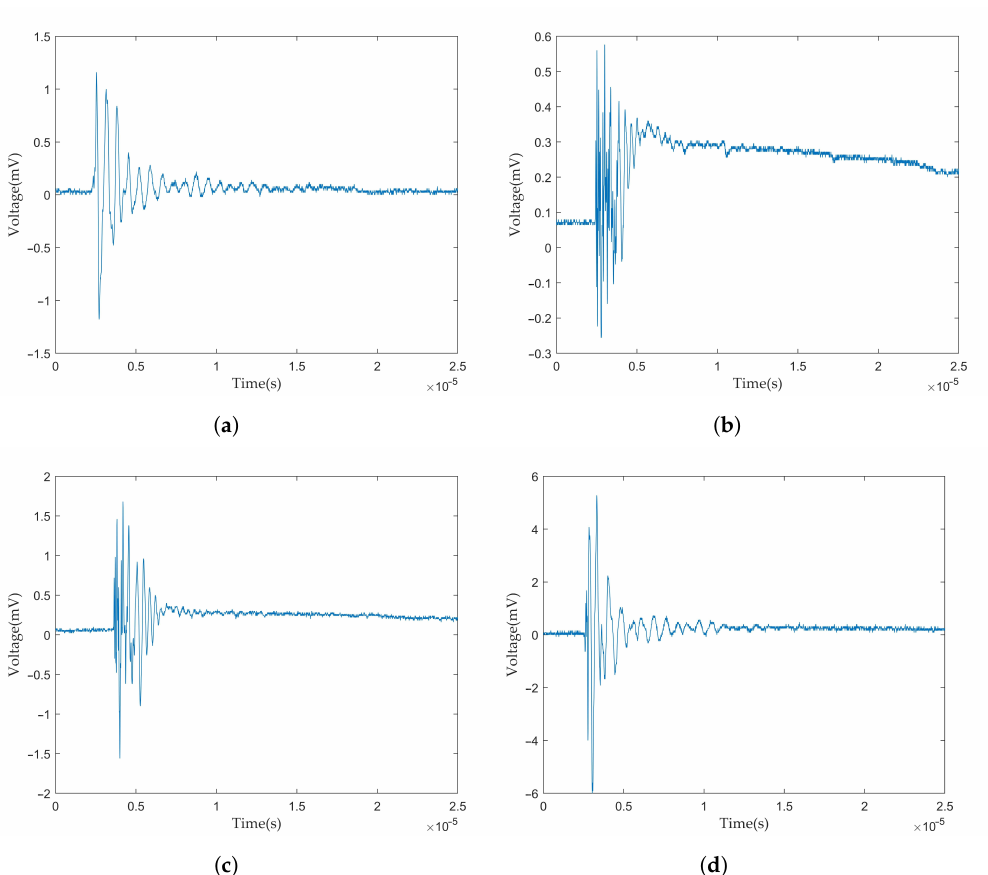
Figure 6. PD pulse waveforms: ( a ) point discharge; ( b ) surface discharge; ( c ) air gap discharge; ( d ) suspended